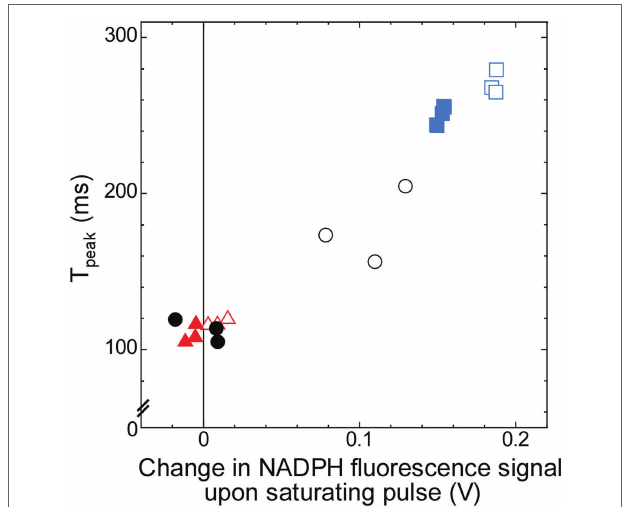
FIGURE 5 | Correlation ( R 2 = 0.952) between T peak , which represents time to reach 93% of P-level of chlorophyll fluorescence (calculated from the data in Figure 4 ), and change in NADPH fluorescence signal upon saturating pulse (calculated from the data in Figure 2 ). Open symbols, cells measured in the absence of glucose; filled symbols, cells measured in the presence of glucose. Black circles, the wild-type strain; red triangles, Δ ndhF1 ; and blue squares, Δ gnd